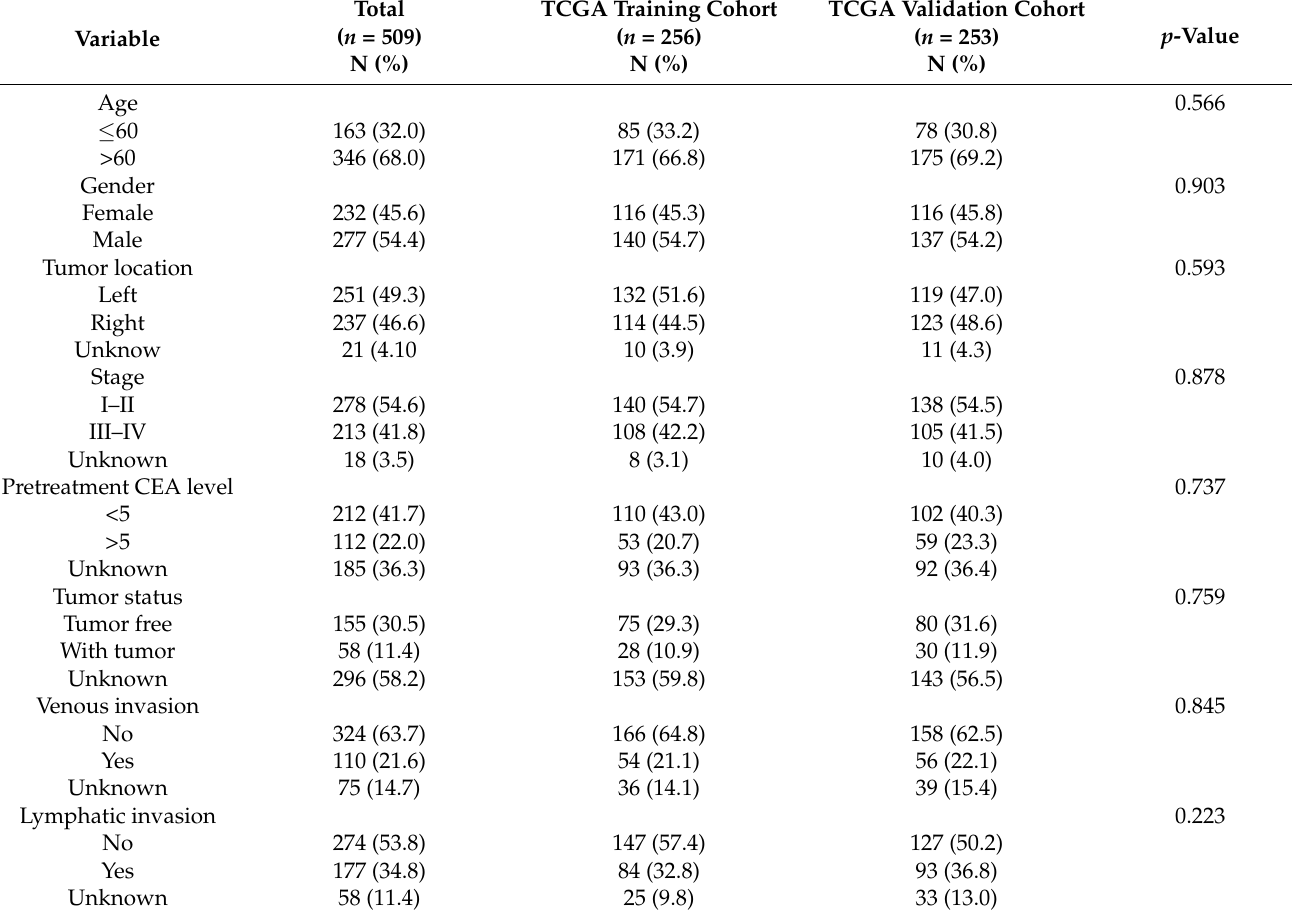
Table 1. Clinicopathologic characteristics of colorectal cancer patients in the TCGA